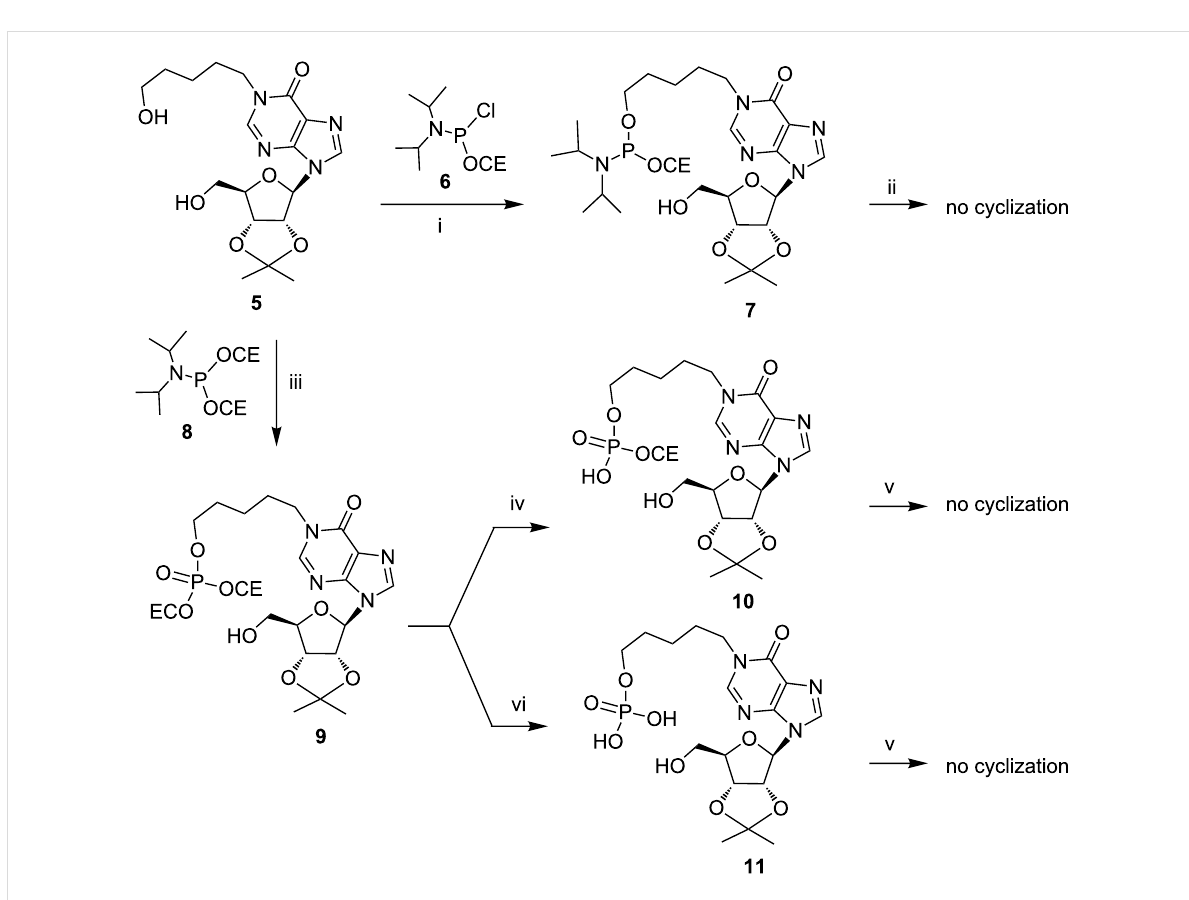
Scheme 1: i) (iPr) 2 NP(OCE)Cl, DIPEA, THF, 1 h, rt; ii) 1) 1 H -tetrazole, THF, 2) t -BuOOH, 2 h, rt; iii) 1) (iPr) 2 NP(OCE) 2 , 1 H -tetrazole, THF, 2 h, rt, 2) t -BuOOH, 2 h, rt; iv) TEA/pyridine, 1:1 v/v, 16 h, rt; v) activating agent (EDC in DMF or DCC in DMF or MSNT in pyridine) 16 h, rt; vi) conc.